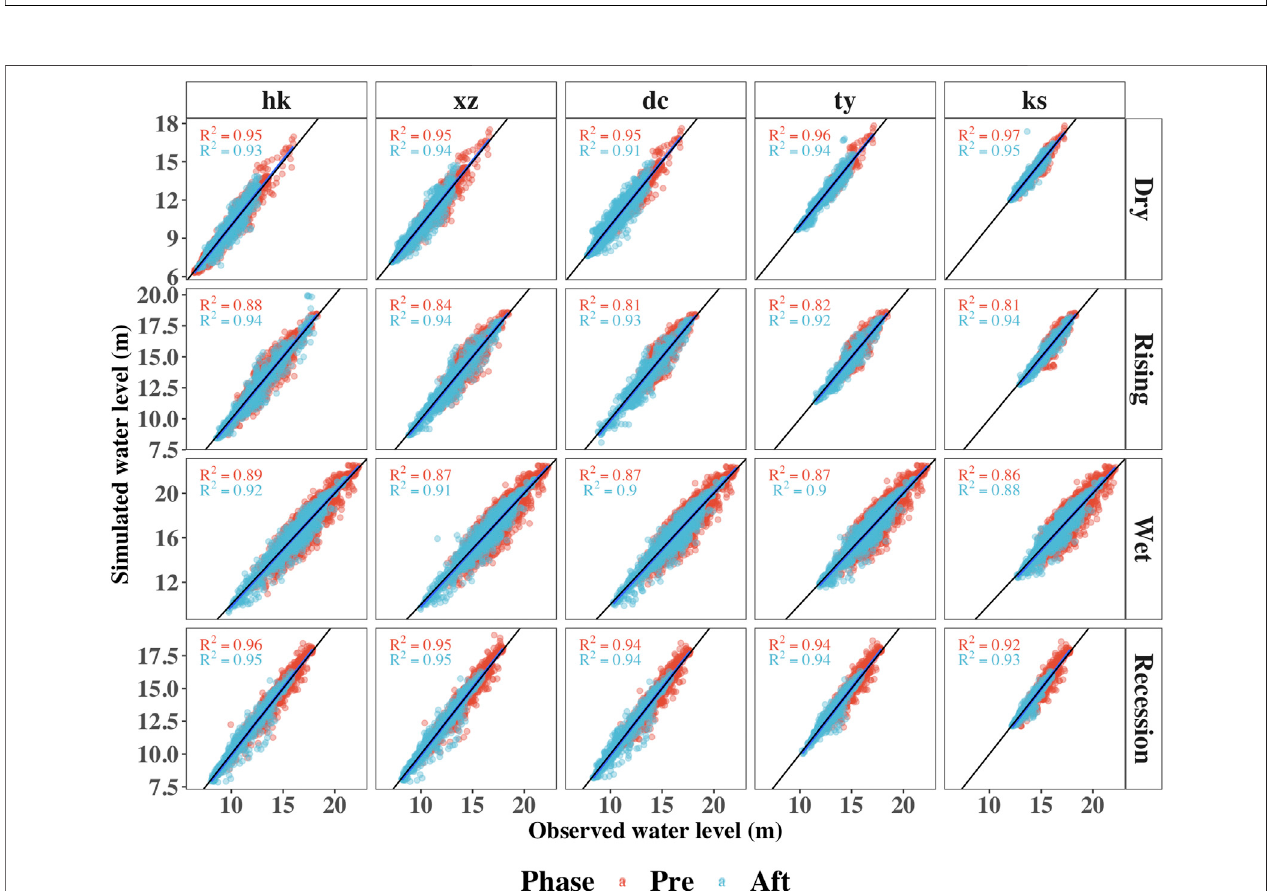
FIGURE3| Observedandsimulatedwaterlevelsofthe fi vegaugingstationsinthedry,rising,wet,andrecessionseasonsfortheout-of-bagtestingsets.Theblack lines represent line of 1:1.